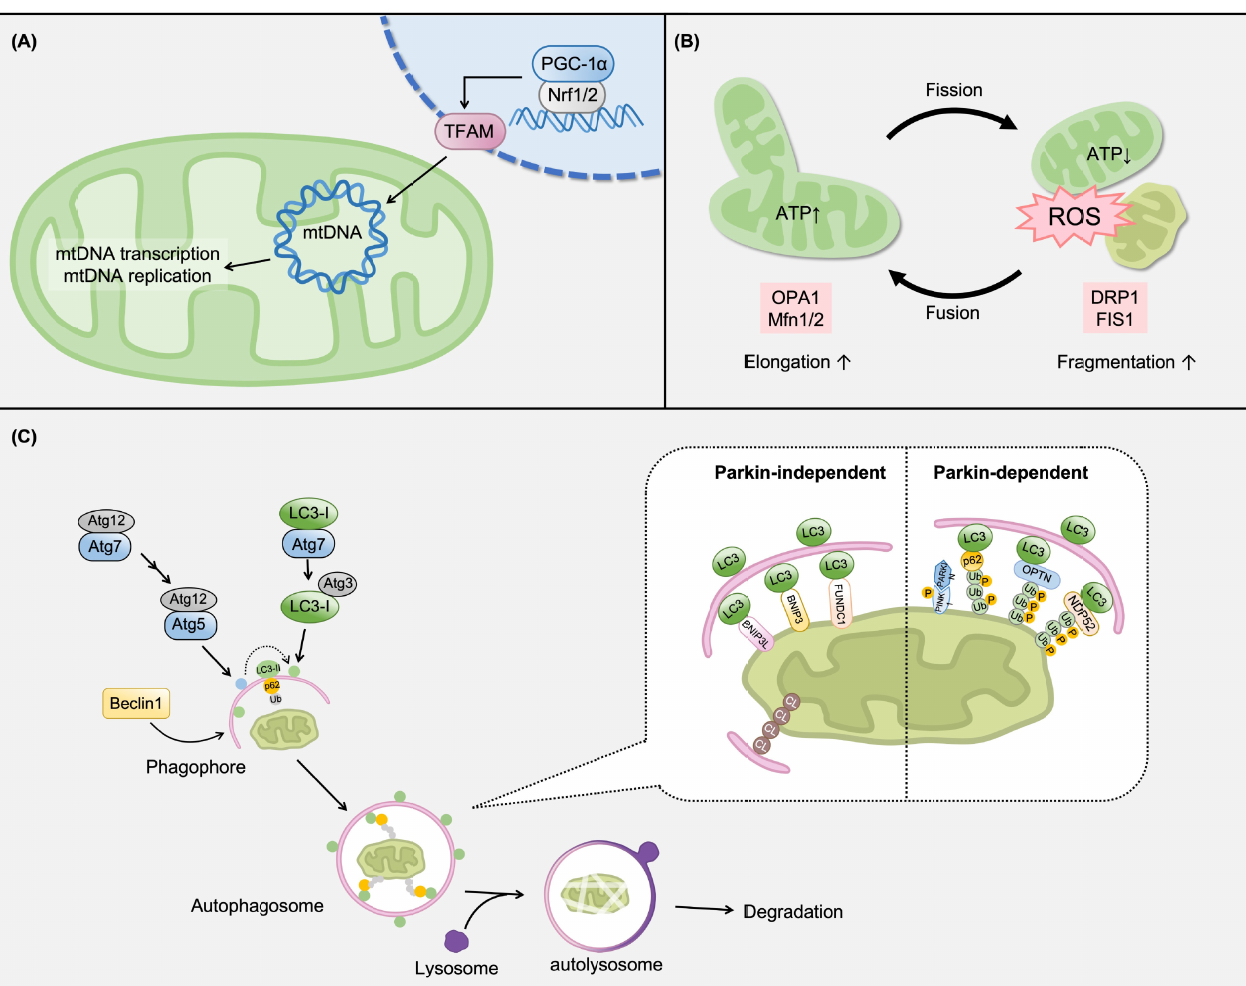
Figure 5. Molecular mechanisms of mitochondrial turnover. ( A ) Mitochondrial biogenesis. Nuclear peroxisome proliferator-activated receptor-gamma coactivator 1-alpha (PGC-1 α ) activates its target genes Nrf1/2. Transcription factor A, mitochondrial (TFAM) promotes mtDNA transcription and replication to generate new mitochondria. ( B ) Mitochondrial fusion/fission. Mitochondria are highly dynamic organelles that frequently fuse and divide. Mitochondrial fusion is mediated by mitofusins (Mfns) and optic atrophy protein 1 (OPA1). Mitochondrial fission is mediated by dynamin-related proteins and mitochondrial fission 1 protein (FIS1). ( C ) Mitophagy. Mitochondrial quality control systems are essential for the maintenance of functional mitochondria. Mitophagy is the selective degradation of mitochondria by autophagy. In mitophagy, the target mitochondria are recognized by the autophagosomes and delivered to the lysosome for